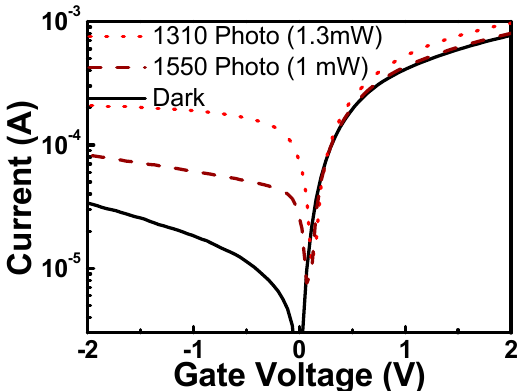
Figure 2. The current–voltage ( IV ) characteristics of the thin-film Ge photodetector (i.e., control sample). The power coupled to the edge of the gate electrode is 1.3 and 1 mW, respectively, for the 1310 and 1550 nm infrared lights.